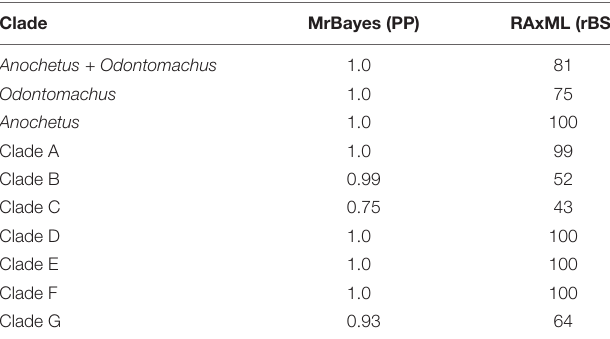
TABLE 2 | Support values for Bayesian Inference Posterior Probability (PP) and Maximum Likelihood (BS) with the respective groups of the genus Anochetus and Odontomachus